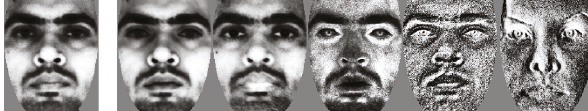
Figure 5: Five principal band images of one subject after PCT.